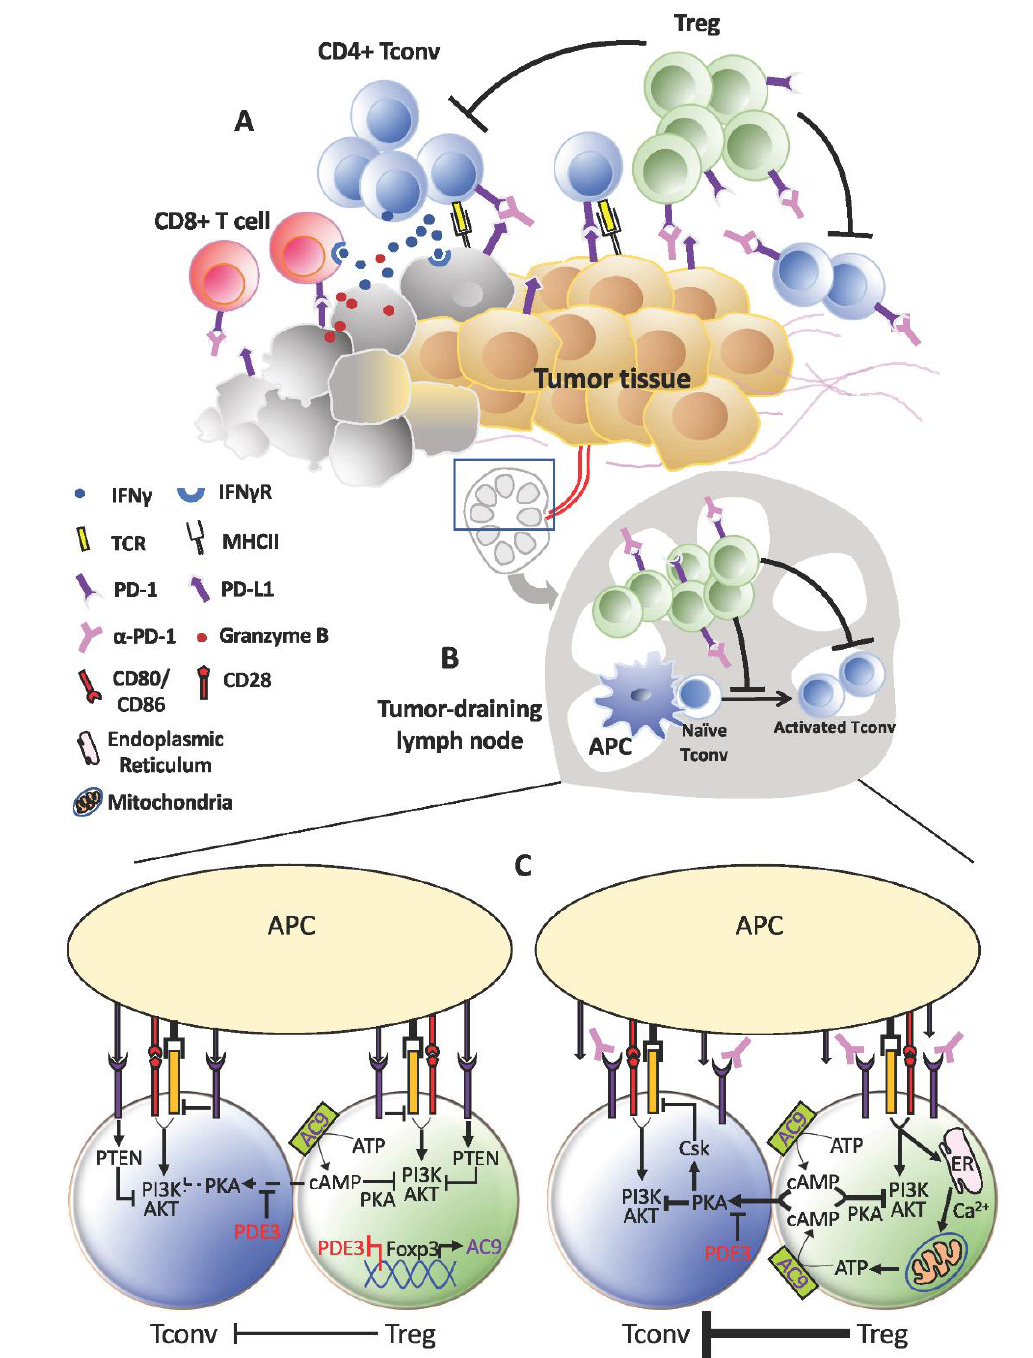
Figure 2. Treg expansion behind hyper-progressive disease (HPD). ( A ) Within the tumor, the anti-tumor effects of pro- grammed cell death protein 1 (PD-1) blockade on effector T-cells may be short-lived due to the activation and expansion of Tregs. This could be even more pronounced in tumors that contain higher proportions of PD-1 + Tregs relative to T- effector cells. Consequently, tumor cells that escape continue to thrive and proliferate. ( B ) A similar occurrence may take place in the lymphoid organs where a more active Treg population resists fresh generation of anti-tumor T-effector cells. As anti-tumor immunity wanes, tumor progresses unhindered and may even accelerate in the form of HPD. ( C ) At the cellular level, increased TCR signaling in Tregs devoid of PD-1 signaling may drive increased calcium influx and adeno- sine triphosphate (ATP) production, which in turn elevates cAMP generation and transfer into Tconv cells. Consequently, TCR stimulation in Tconv cells could still be subdued by the PKA:Csk despite absence of PD-1 inhibitory signals.